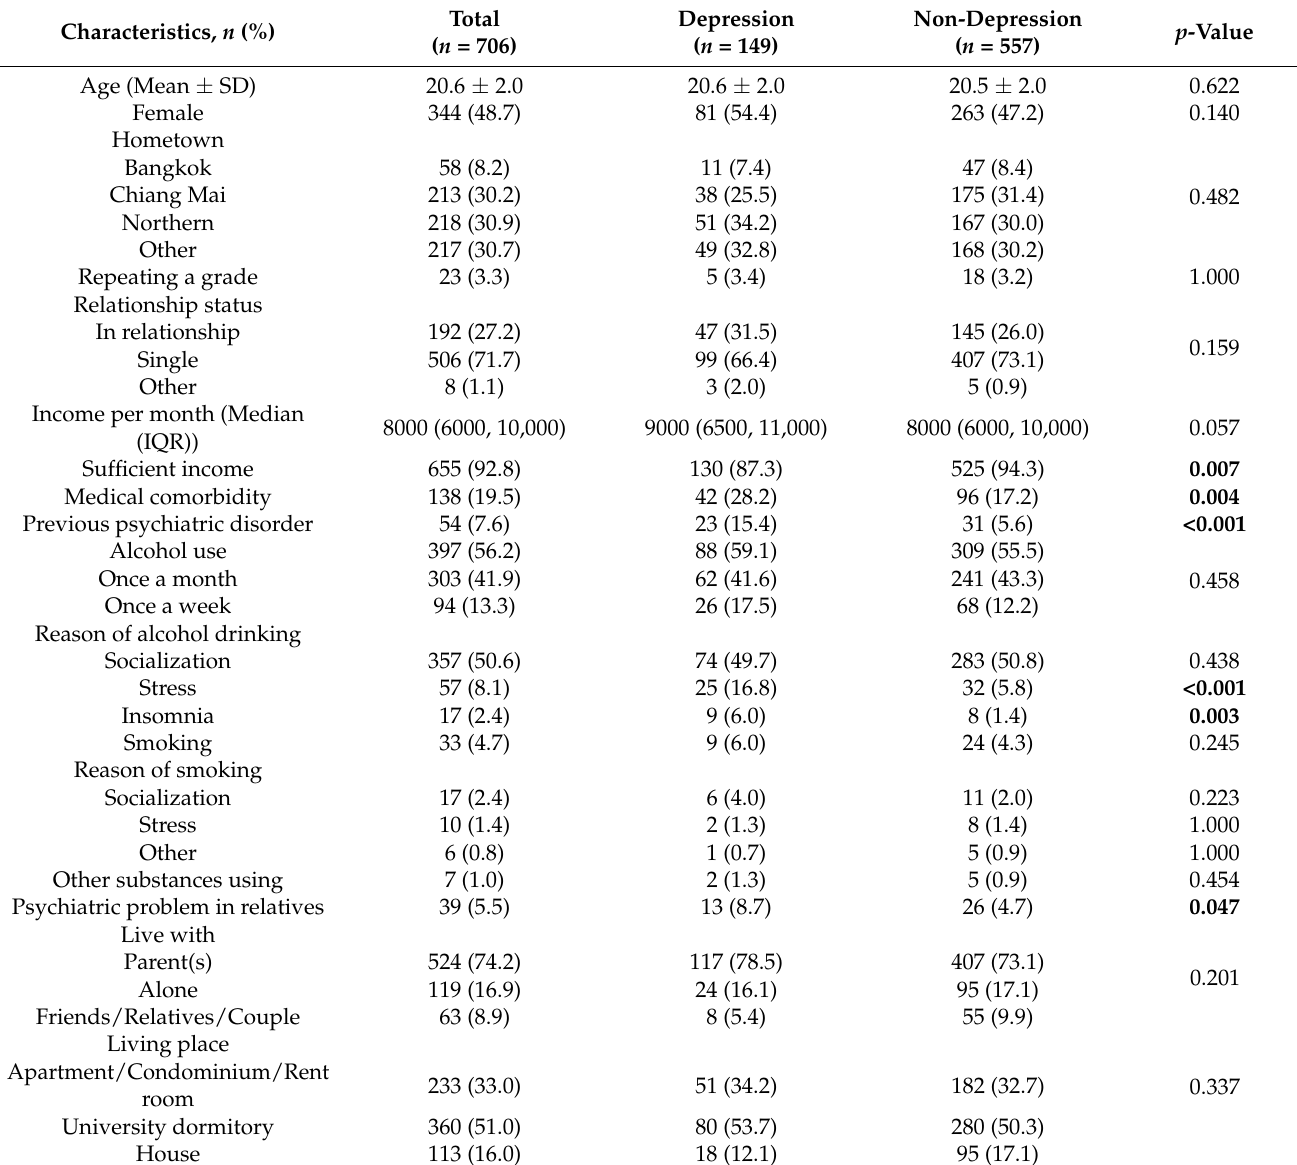
Table 1. Participants’ demographic